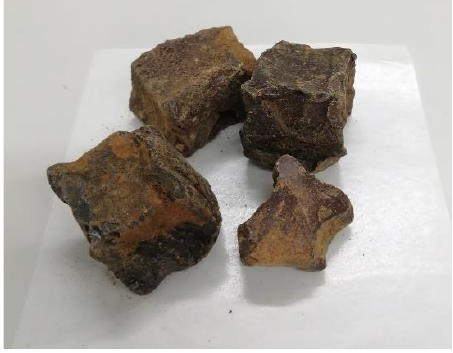
Figure 1. Appearance of catechu blocks.